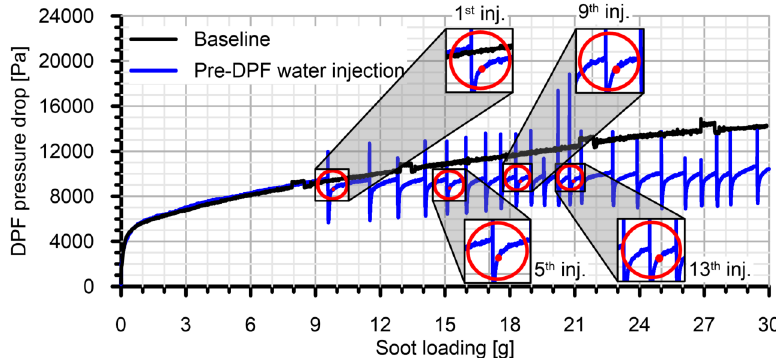
Figure 2. Soot loading test in DPF #A defining the conditions of the parametric